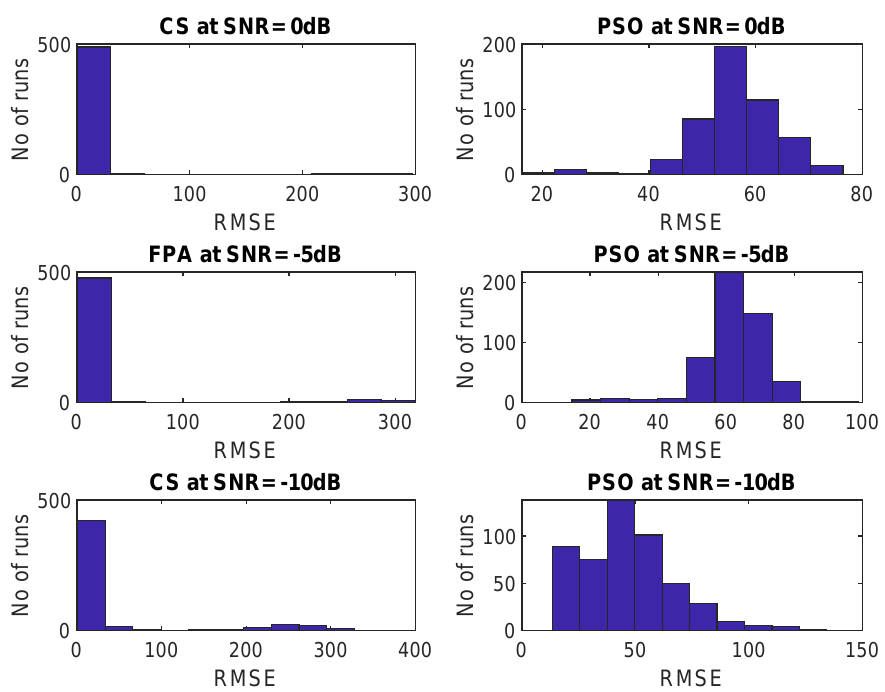
Figure 18. Correlation of proposed CS and PSO models based on RMSE using twelve